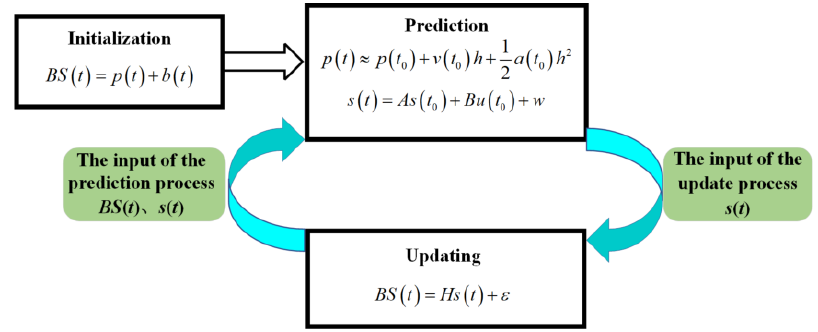
Figure 6. Prediction and updating process of BS signal by the Kalman